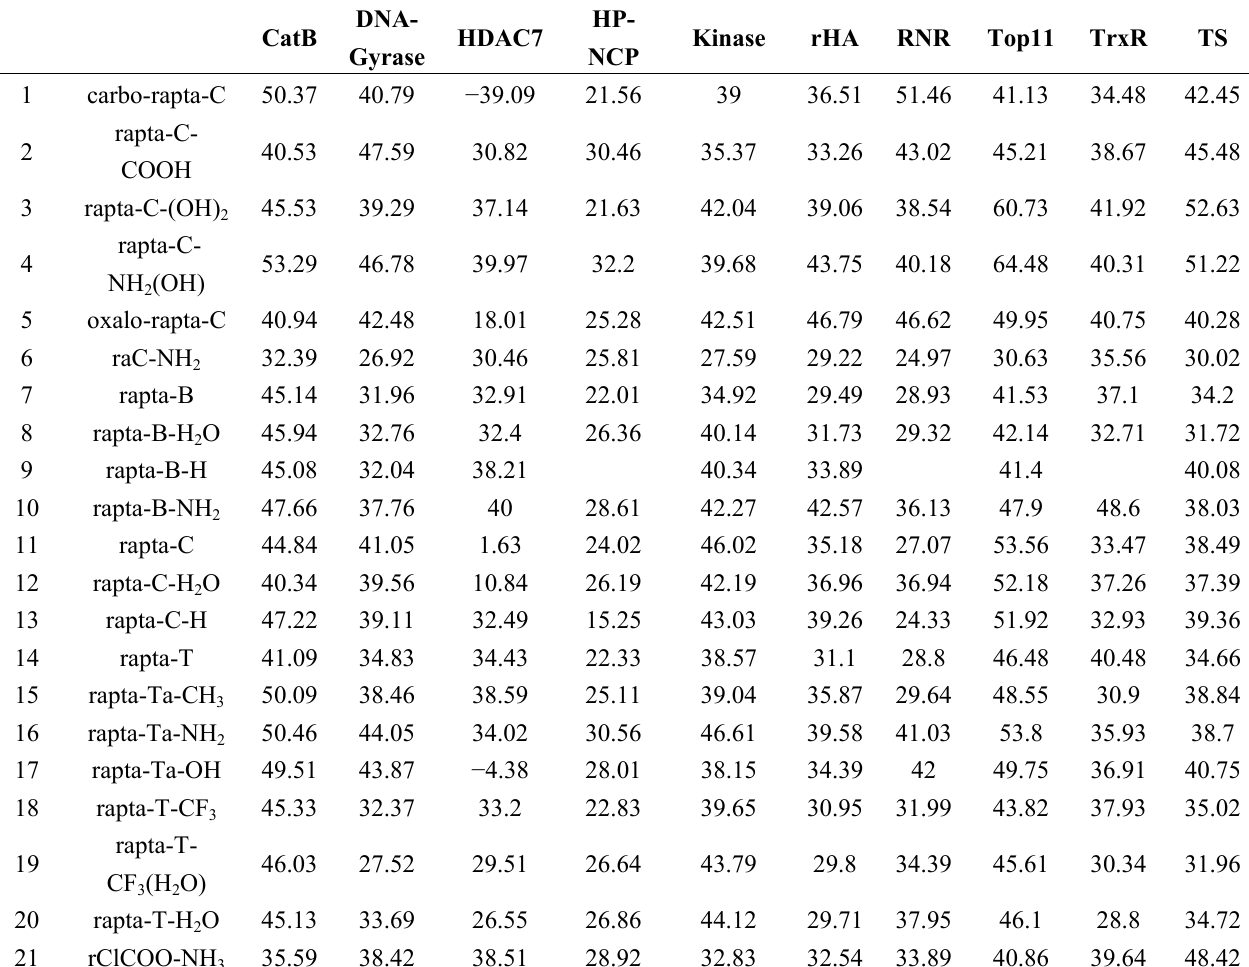
Table 3. The docking prediction for metal-based complexes using